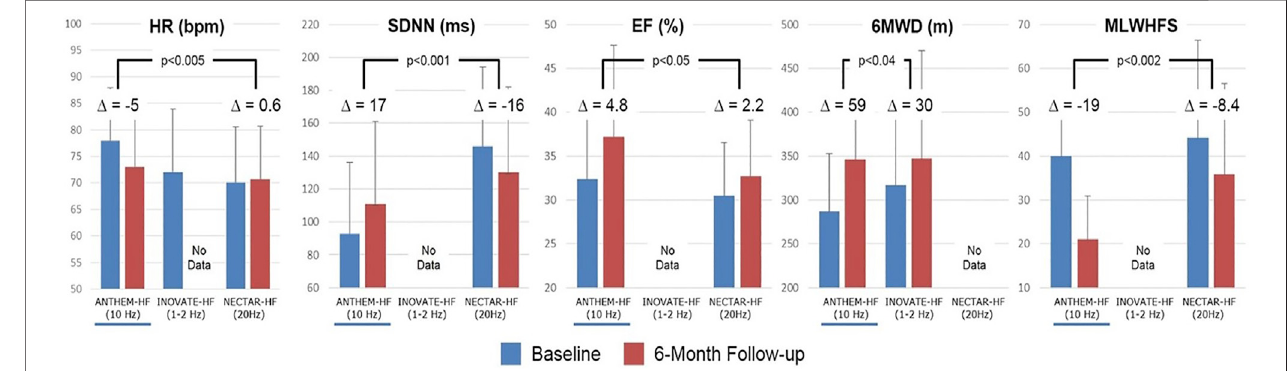
FIGURE 5 | Stimulation frequencies used for VNS and associated changes from baseline in symptomatic and functional outcomes in the treatment arms of ANTHEM-HF,INOVATE-HF,andNECTAR-HF. △ =difference;%=percent;bpm=beatsperminute;Hz=Hertz;m=meters;ms=milliseconds;otherabbreviationsas in the text. p -values are two-sided and are based on two-sample t-tests. From Inand AS, et al. ESC Heart Fail 2020; 7: 76 – 84, with permission.